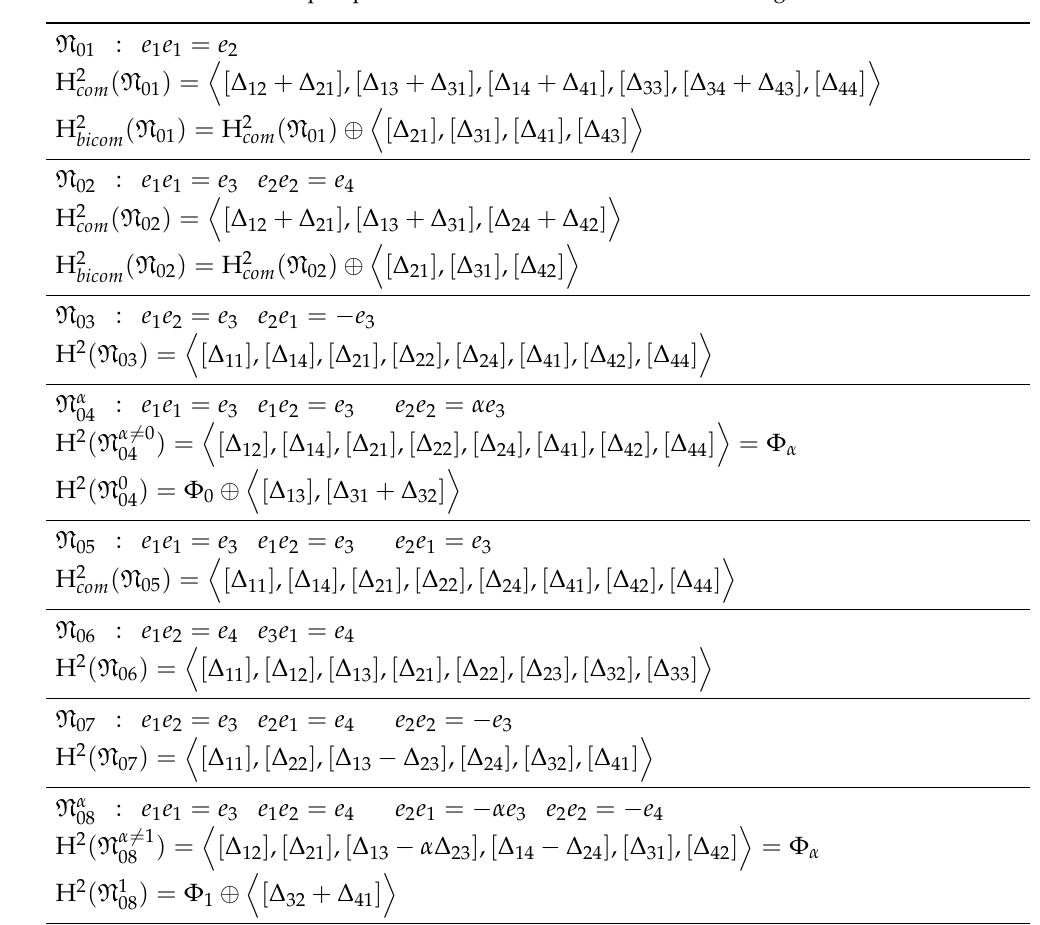
Table 1. The list of two-step nilpotent four-dimensional bicommutative